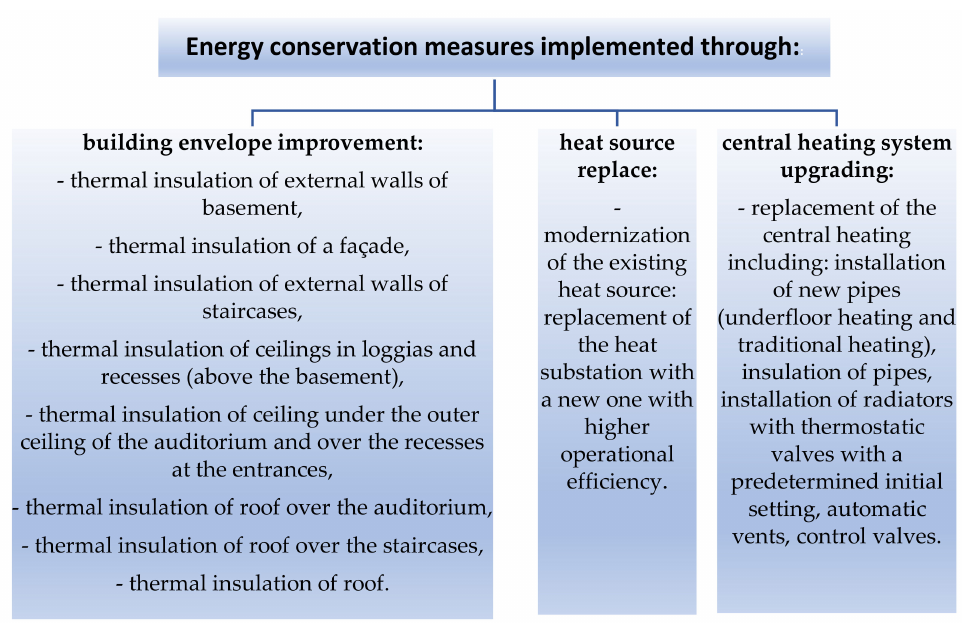
Figure 5. Energy conservation measures implemented in the analyzed